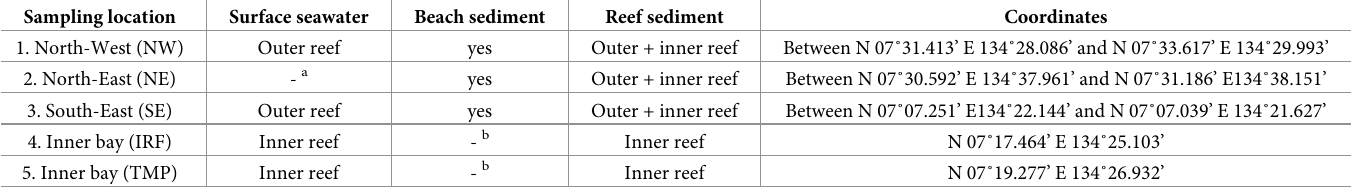
Table 1. Overview about the different sampling locations.